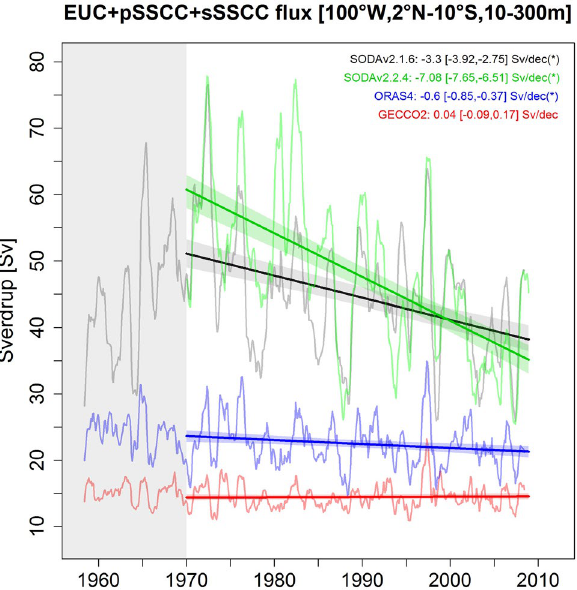
Figure 4. Near-equatorial eastward mass flux trends over 1970–2008. Eastward flux (in Sv) at 100° W associated with the near-equatorial eastward undercurrents (EUC, pSSCC, sSSCC) for 4 different reanalysis global products over 1958–2008: SODAv2.1.6 (black), SODAv2.2.4 (green), ORAS4 (blue), GECCO2 (red). Linear trends over 1970–2008 and confidence intervals are indicated in the upper right side of the figure and asterisks indicate statistical significance. The figure was generated using the software R (R Core Team, version 4.1.1., http:// www.R- proje ct.